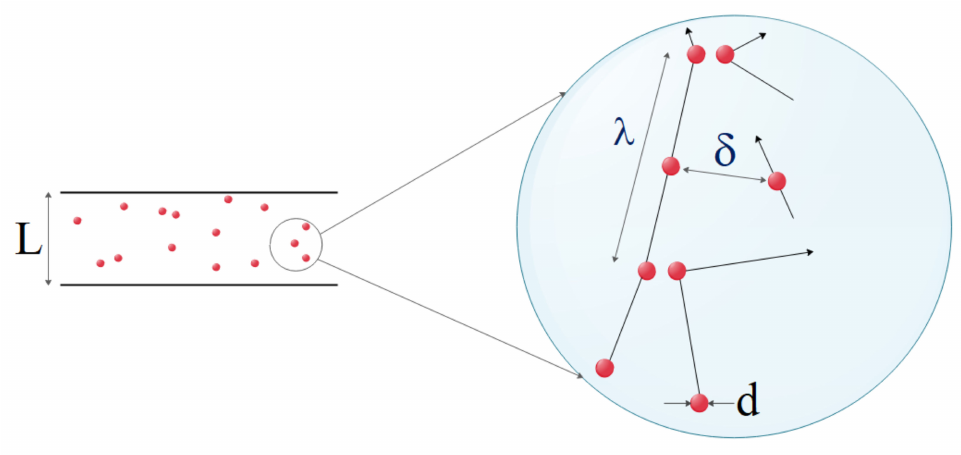
Figure 2. Effective parameters in molecular level modeling